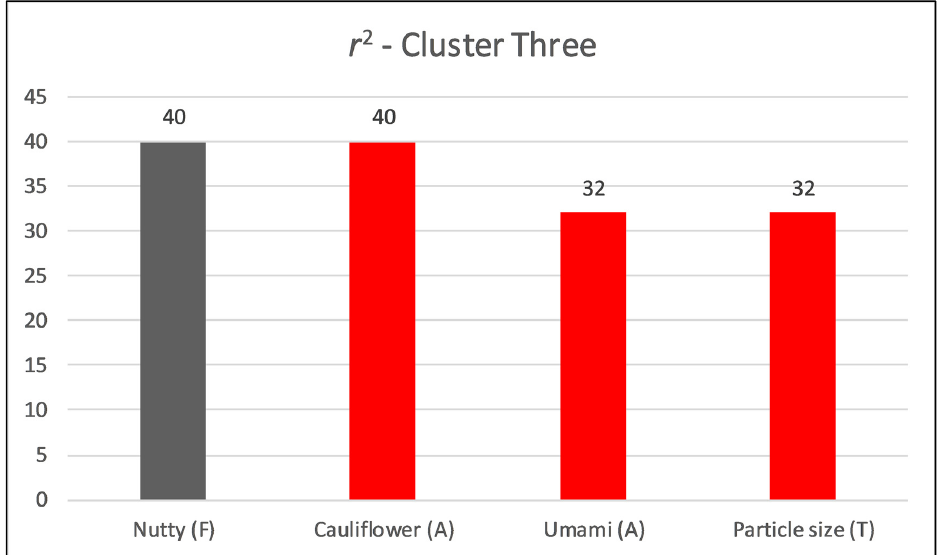
Figure 6. Coefficient of determination ( r 2 ) for the relationship between overall liking and sensory attributes (polynomial equation used for r 2 ; red bars show negative drivers of liking).